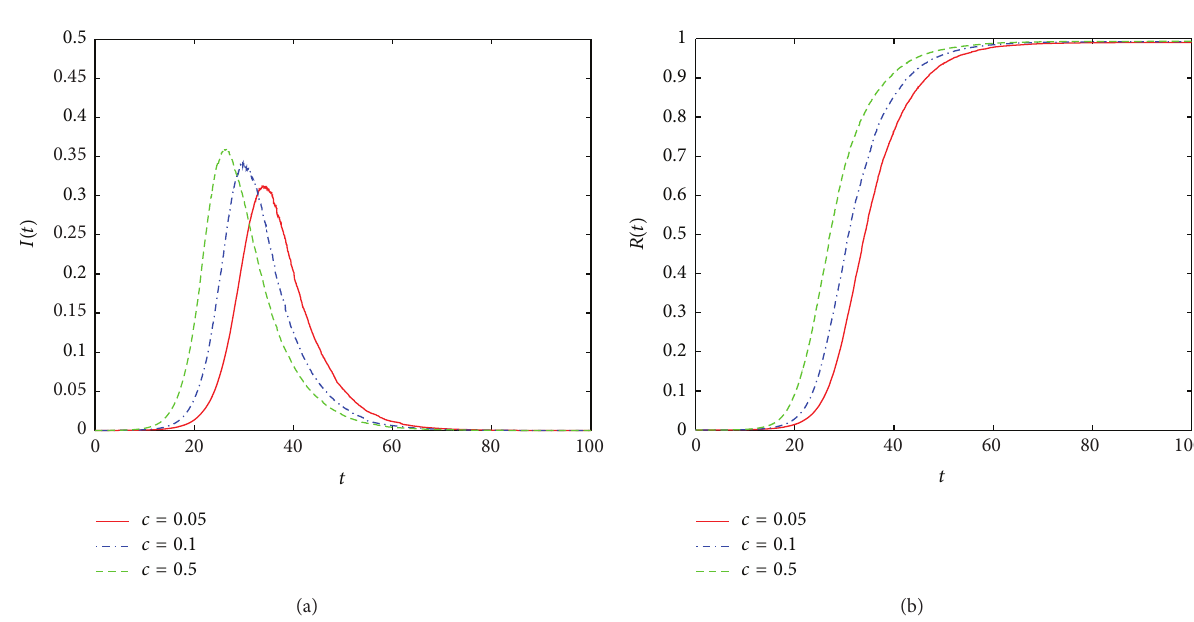
Figure 7: Density of spreaders and stiflers on BA